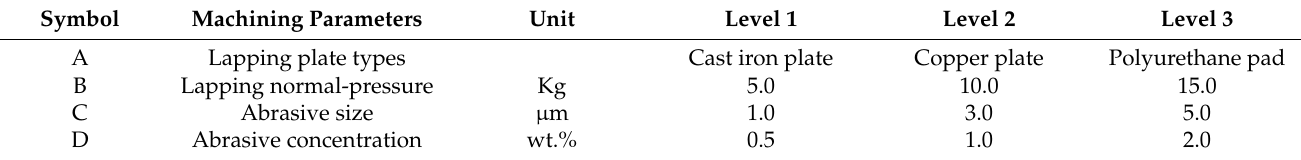
Table 1. Machining parameters and their levels.